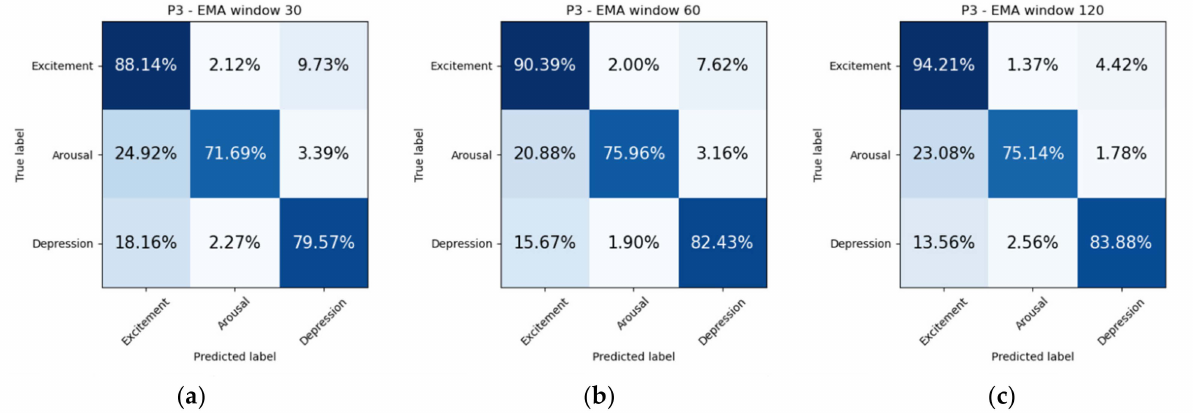
Figure 14. Confusion matrix for patient P3 for windows ( a ) 30-, ( b ) 60-, ( c ) 120-min. Predicted mood states: Excitement, Arousal and Depression.